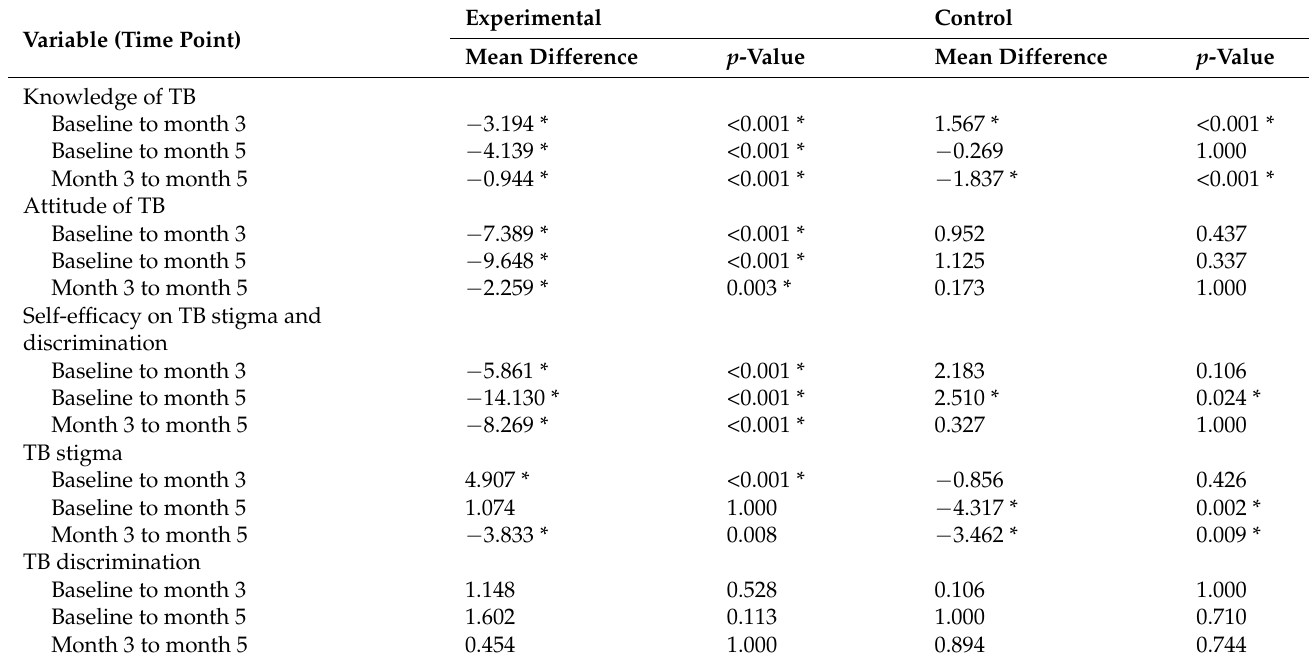
Table 3. Comparison results and mean score differences of knowledge of TB, attitude of TB, self- efficacy on TB stigma and discrimination, TB stigma and TB discrimination within the experimental ( n = 108) and control groups ( n = 104) at baseline, month 3 and month 5.